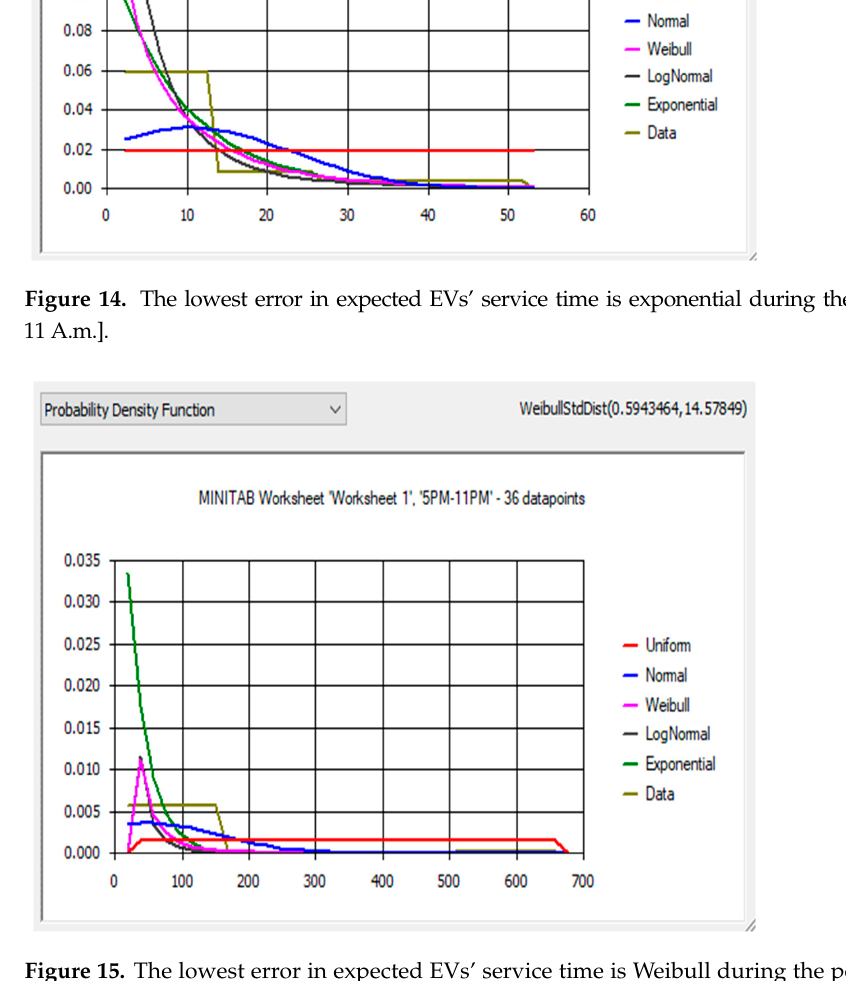
Figure 15. The lowest error in expected EVs’ service time is Weibull during the period [5 Pm: 11 Pm].